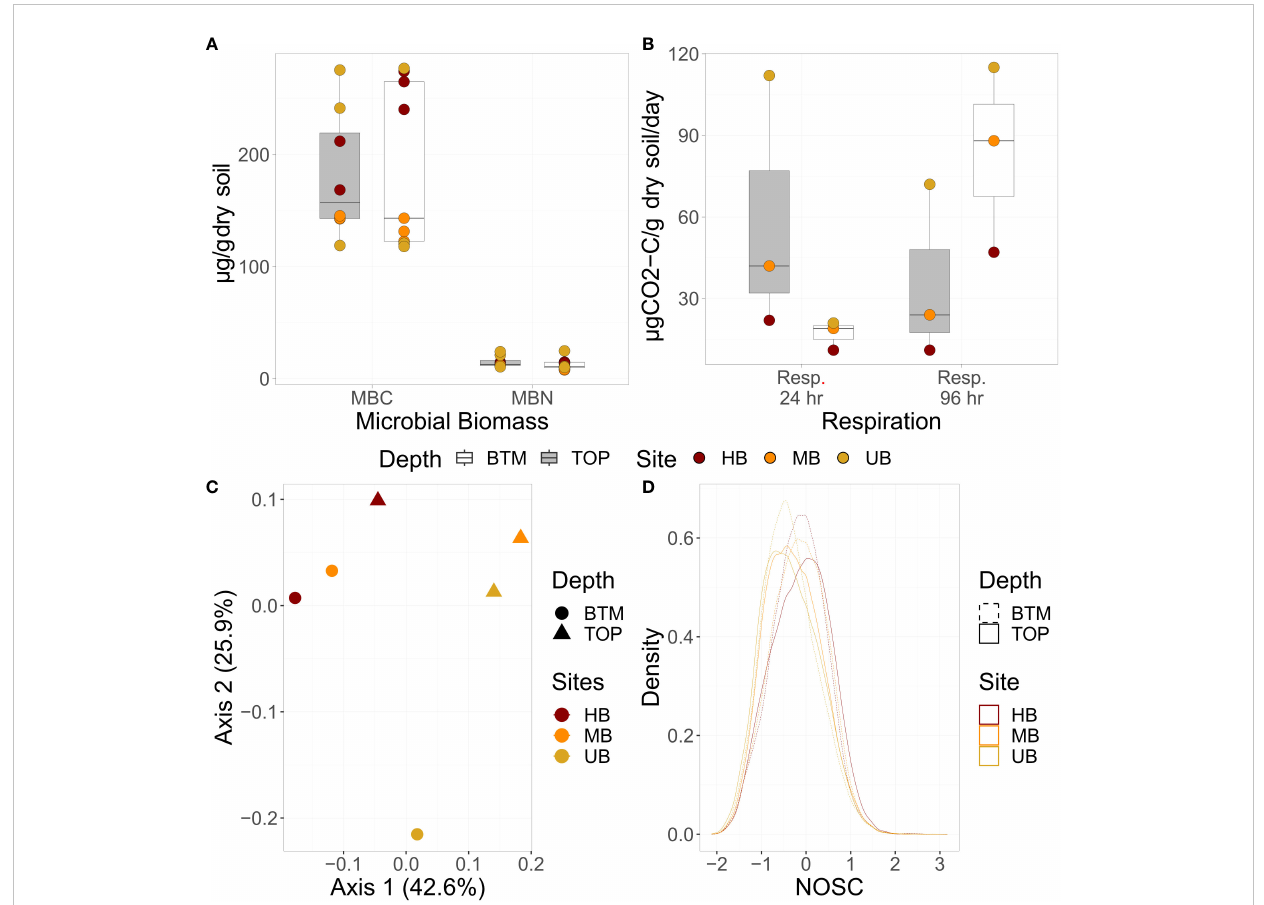
FIGURE 2 (A) Microbial biomass C (MBC) and N (MBN) concentrations, (B) respiration (24 and 96 hr; µg CO 2 -C/g dry soil/day), (C) SOM composition, and (D) NOSC of SOM pro fi les. (A, B) are boxplots where the median is represented by a line, the edges of the boxes re fl ect 25 th and 75 th percentile, and the end of the whiskers re fl ect the minimum and maximum. (C) shows a principal component analysis of SOM composition, and (D) displays a density curve of NOSC values for each sample. For all plots, UB, MB, and HB are denoted in yellow, orange, and red respectively. In (A, B) data from top and bottom sections are denoted by grey and white boxes respectively. In (C) , section is denoted by shape, and in (D) , section is denoted by dashed vs. solid